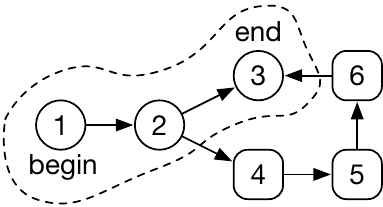
Figure 6. Possible ways to move among locations 1 and